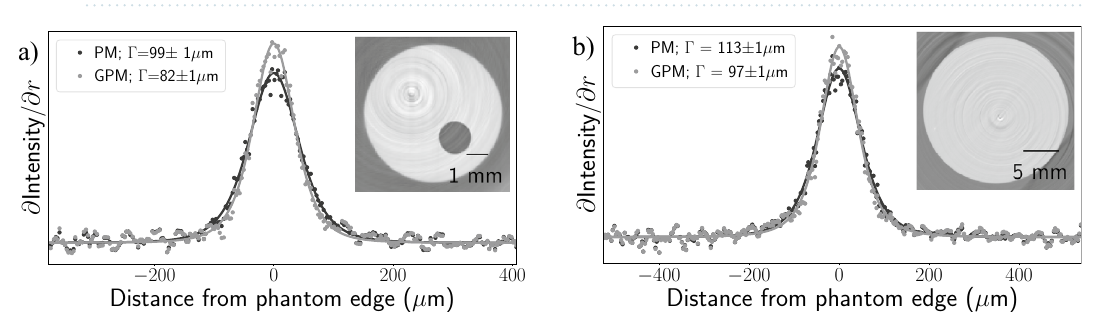
Figure 3. The effect of rebinning the raw phase contrast image ( × n ) upon the spatial resolution of the phase- retrieved images, using the PM and GPM methods. ( a ) Plots the transfer function fractional difference, Eq. (12), along the ( k x , k y = 0 ) line, for various levels of rebinning. Here the filter conditions were chosen to initially match the detector PSF and the conditions used in ( b ) which shows the Pearson VII fit reconstructions of imaging system PSF measurements conducted at the outer edge of a cylindrical PMMA phantom, shown in inset.